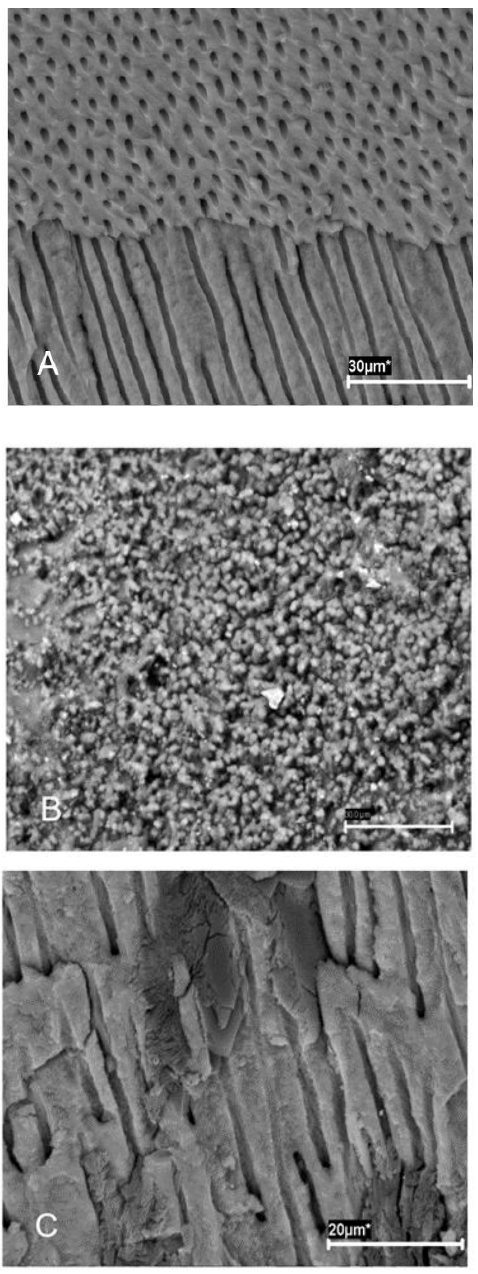
Figure 2. Scanning electron micrograph of dentinal surfaces. ( A ) Uninfected teeth. ( B ) Mature bio- films 21 days post-infection. ( C ) Clean dentine after sponge removal in infected teeth.